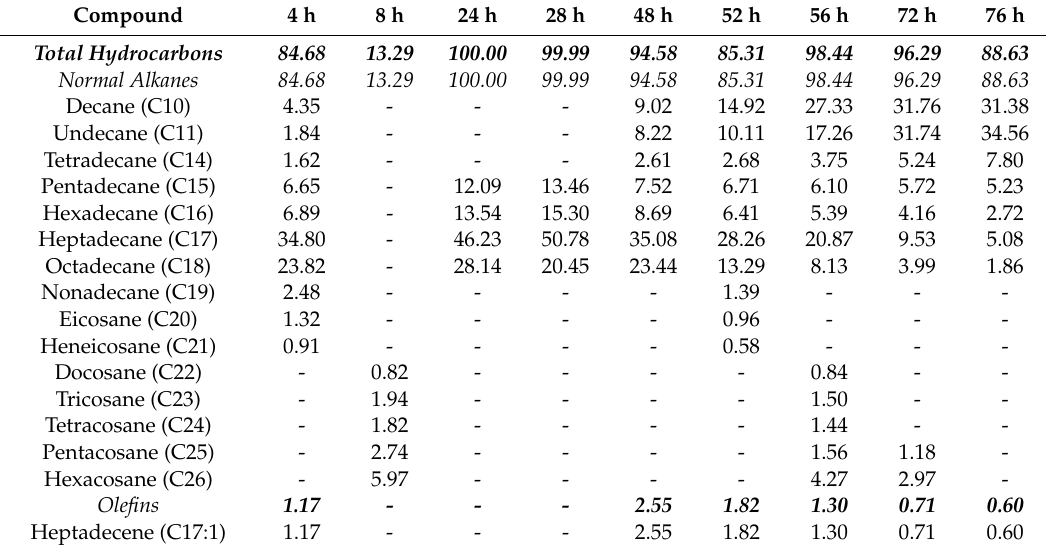
Table A4. GC-MS analysis of the liquid products from the catalytic upgrading of used cooking oil (75 wt.% in C12) over 20% Ni-0.5% Pt / Al 2 O 3 at 375 ◦ C and WHSV = 1.0 h − 1 , in 100% H 2 . Text in bold corresponds to compound classes comprising the individual compounds listed. Text in italics corresponds to compound sub-classes constituting the individual compounds detected. Values shown are wt.%.